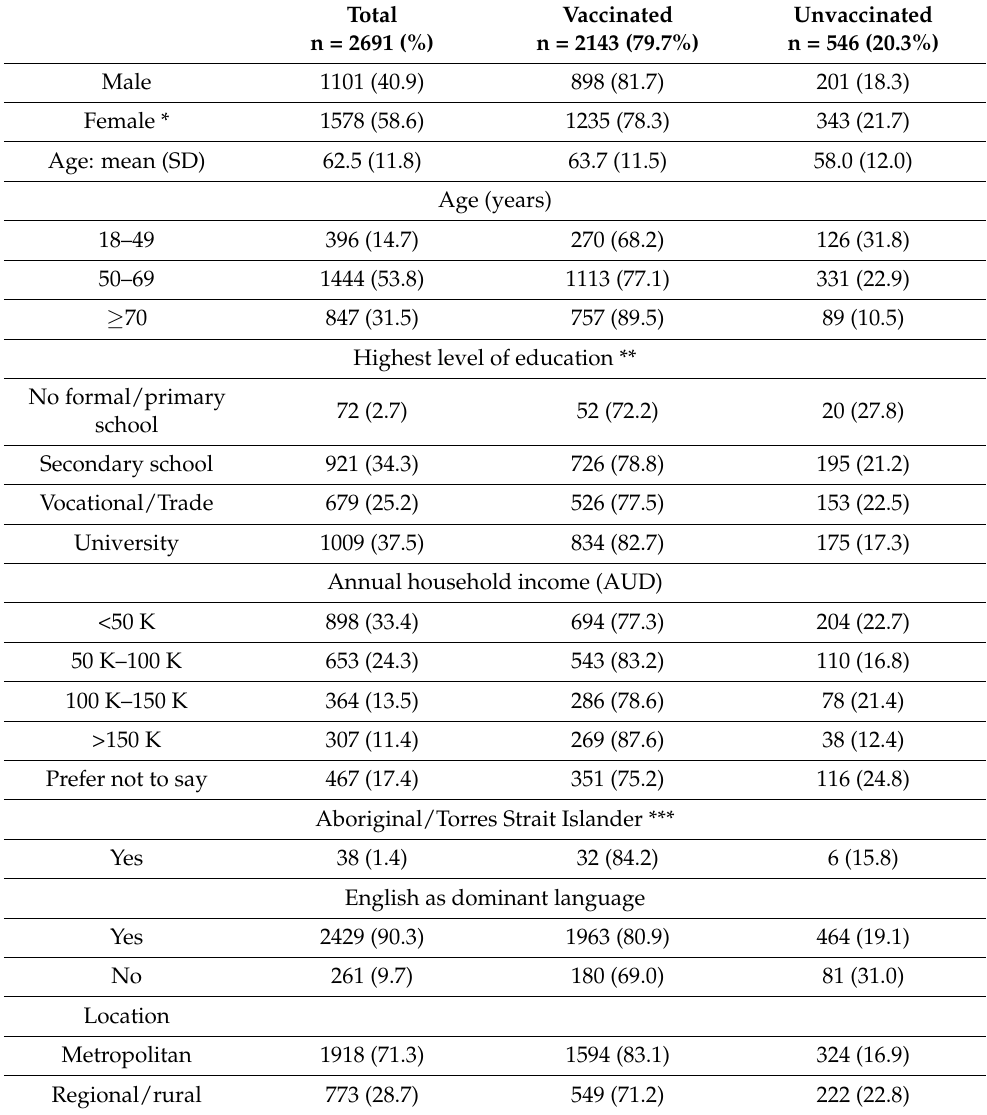
Table 1. Participant